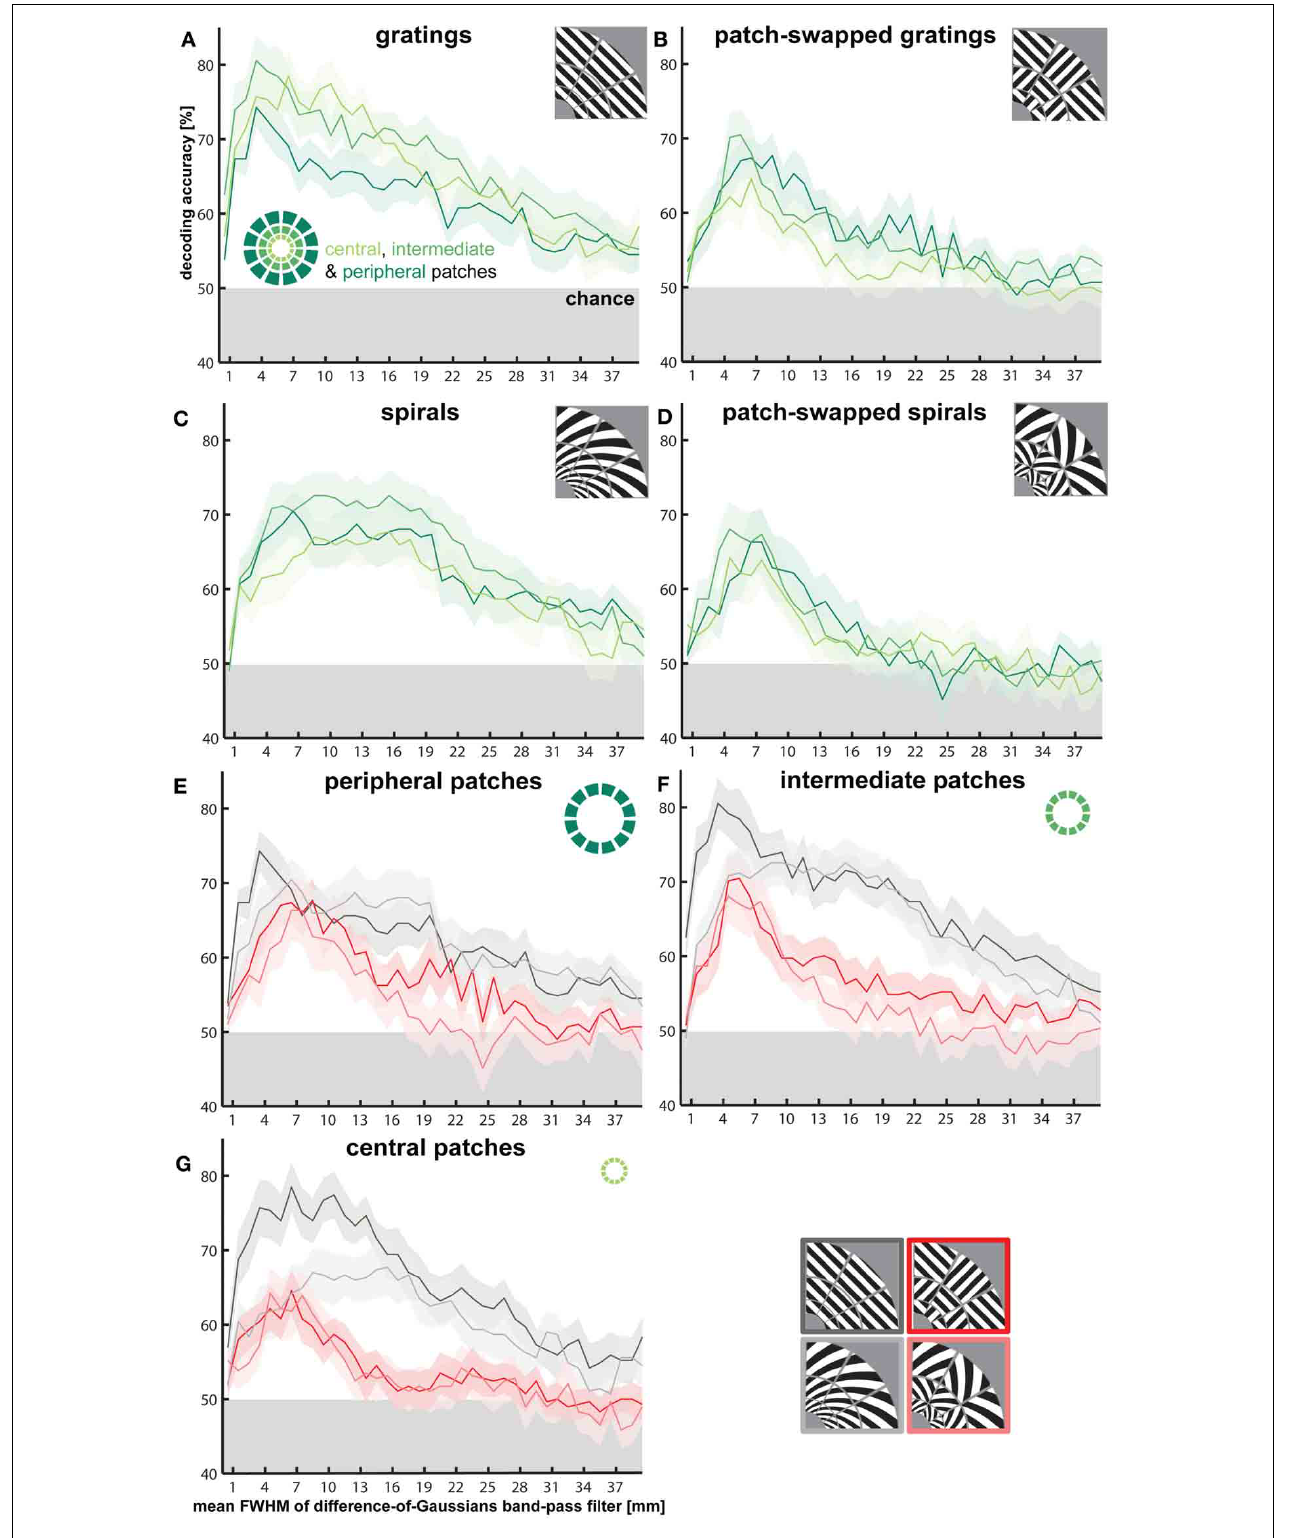
FIGURE 8 | Effects of V1 patch eccentricity on orientation decodability. Same band-pass filtering approach as for Figure 3C , but plotted separately for patterns in the central, intermediate, and peripheral ring of V1 patches. (A–D)